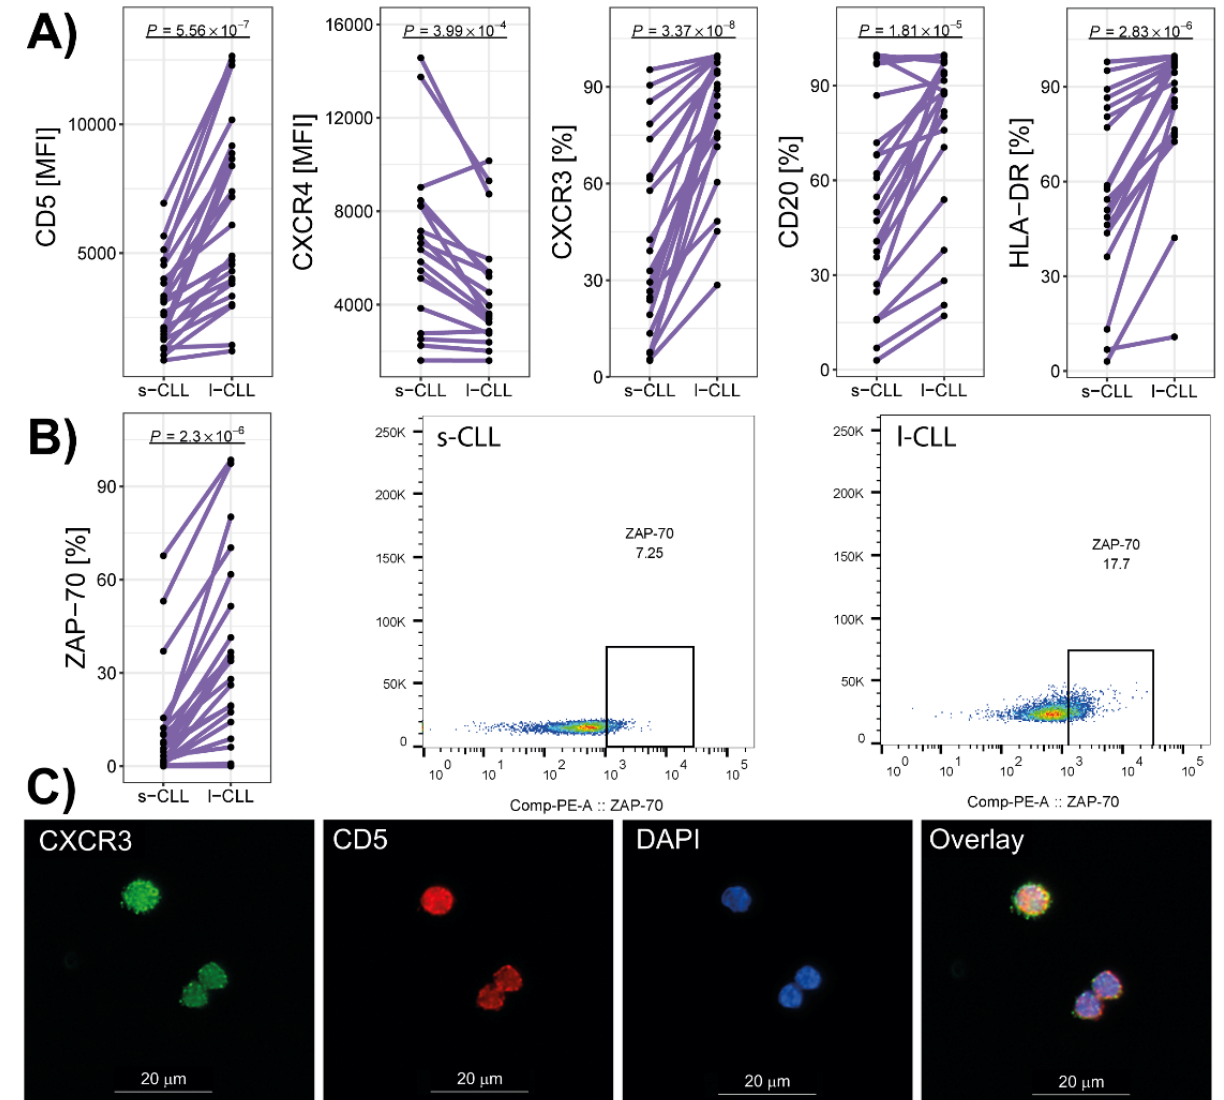
Figure 3. The immunophenotype of s-CLL and l-CLL cells from all the blood samples of the CLL patients. ( A ) The surface expression levels of CD5 and CXCR4, and the percentage of positive cells for CXCR3, CD20, CD38 and HLA-DR. ( B ) The percentage of ZAP-70-positive cells, and representative dot plots of the intracellular expression levels of ZAP-70 in s-CLL and l-CLL cells. ( C ) The double-immunofluorescence staining of s-CLL and l-CLL cells for CXCR3 and CD5; DAPI was used for nuclear